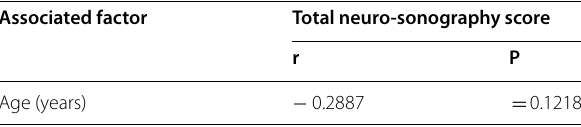
r: Pearson’s rho (correlation coefficient)